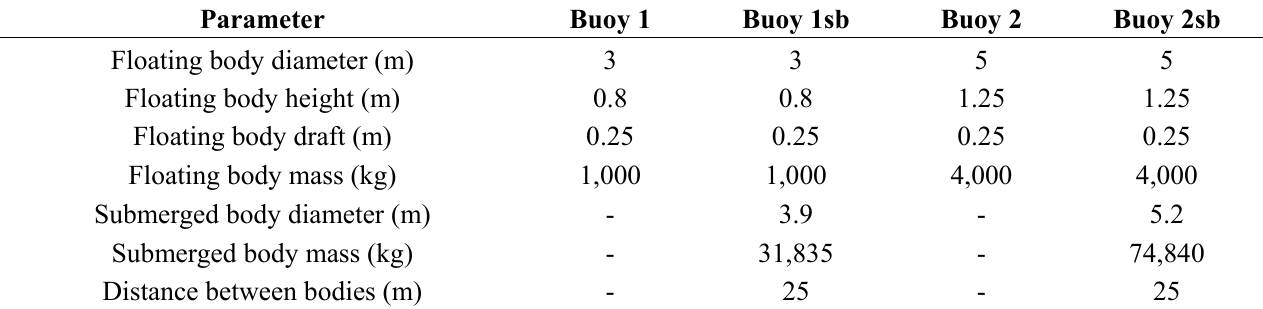
Table 4. Main parameters of the buoy configurations.